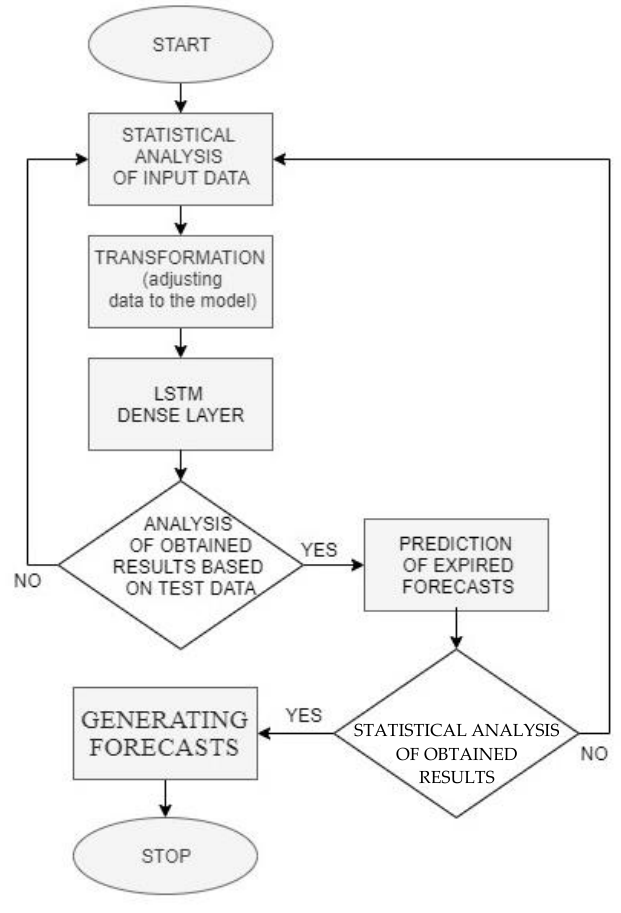
Figure 7. Final electricity consumption by economic sectors, ktoe, source: own study. Statistical analysis - stationarity study, partial Table 1. Long Short-Term Memory (LSTM) network parameters.